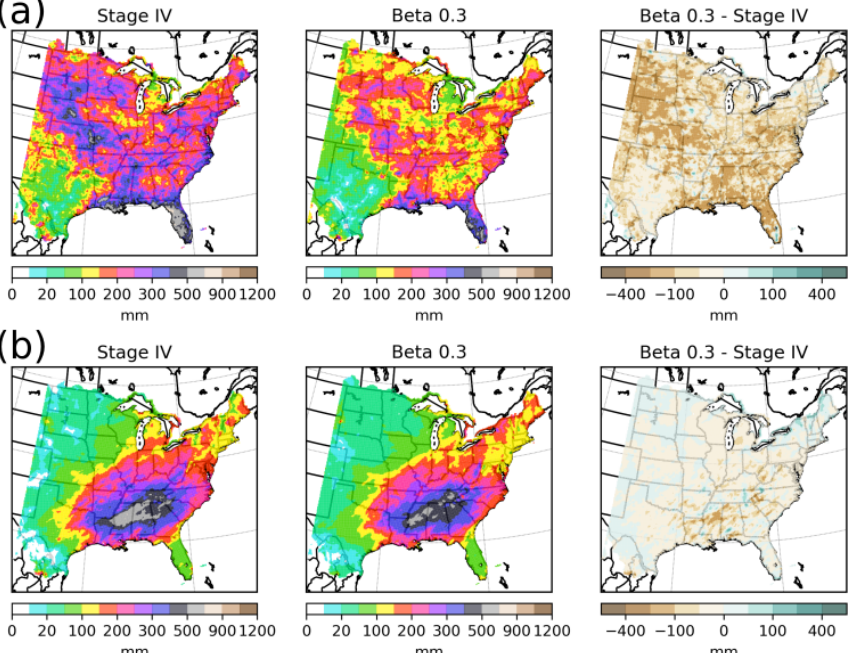
Figure 5. Panel (a) displays the 6h precipitation accumulated over the summer for ST4 (left), for CaPA with β = 0 . 3 (middle), and the difference between the two (right). Panel (b) is the same as panel (a) but for the winter